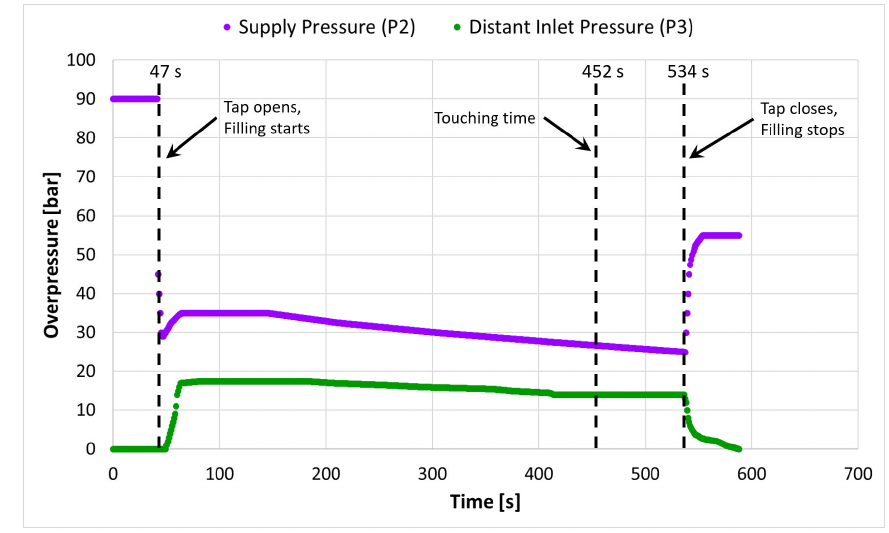
Figure 11. Supply pressure and distant inlet pressure pro fi les of a “Top” case measurement.